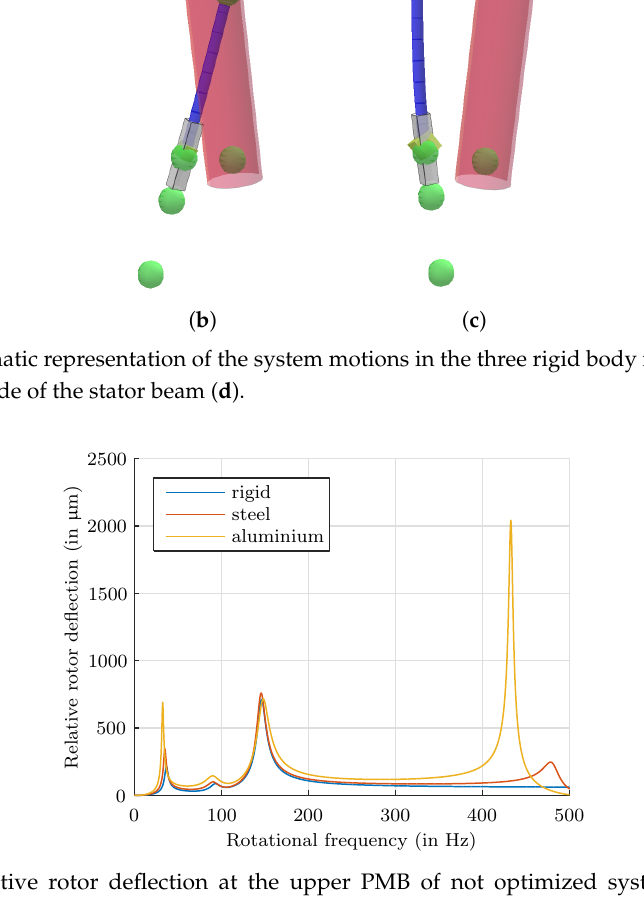
Figure 9. Relative rotor deflection at the upper PMB of not optimized systems with different shaft